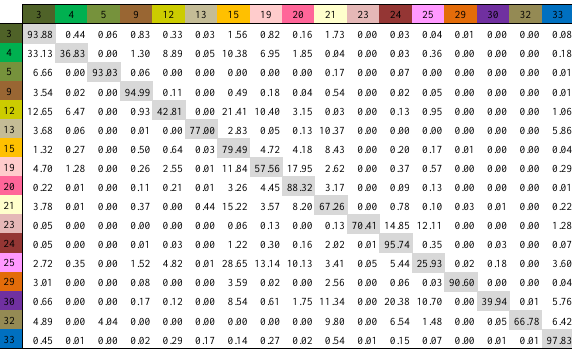
Table 2. Transition matrix of LUCC in São Paulo State between the years 2000 and 2015 (unit: % of area). Proportions were calculated according to the year 2000 (rows). Cells filled with gray colors represent the percentage of persistence area in the class between these years. Names of categories related with these ID’s are shown in Table 1